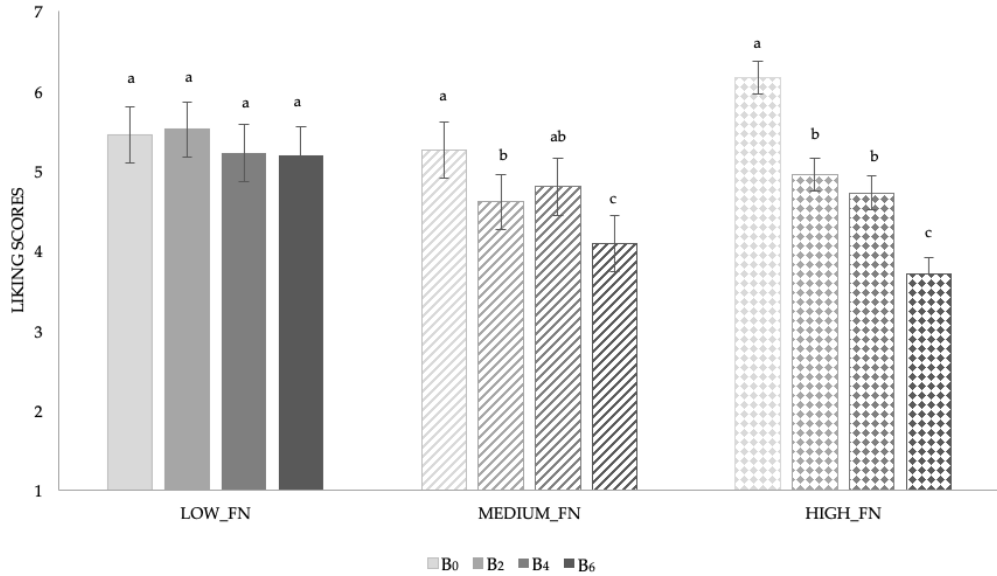
Figure 3. Mean liking scores ± SEM by samples according to food neophobia levels. Different letters indicate significant differences according to post hoc test for each sample. B 0 = 0%; B 2 = 2%; B 4 = 4%; and B 6 = 6% of mushroom powder.